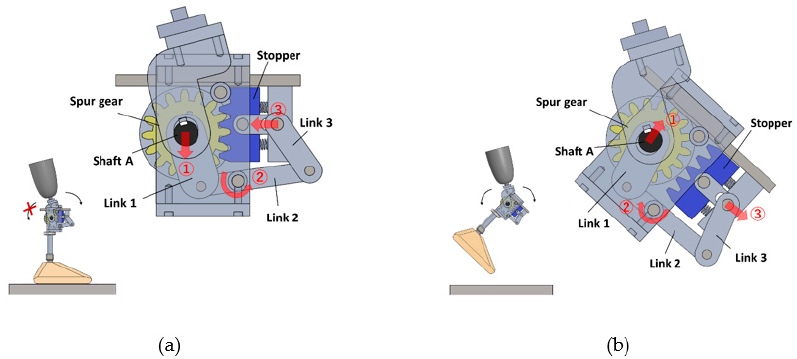
Figure 2. Mechanism of the proposed prosthetic knee. ( a ) Stance phase; ( b ) swing